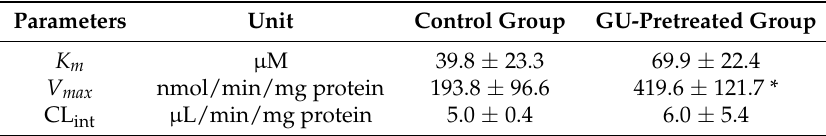
Figure 5. Lineweaver-Burk plot of 5, 10, 20, 30, and 50 µ m KM that received or did not receive GU following 30 min of incubation. Table 6. K m , V max , and CL int for koumine that received or did not receive GU decoctions in rat liver microsome